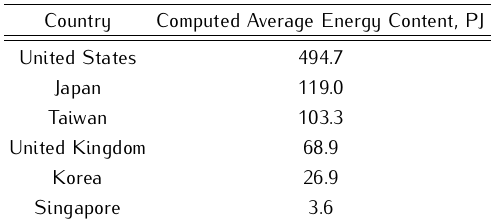
Table 2. Computed Annual Average Energy Content of Food Wastes from Different Countries in 2010